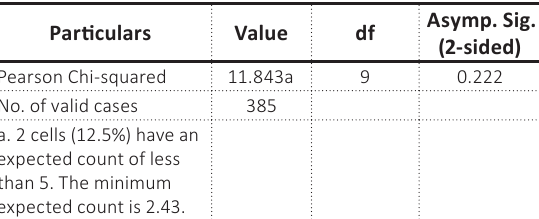
Table 16. Chi-squared